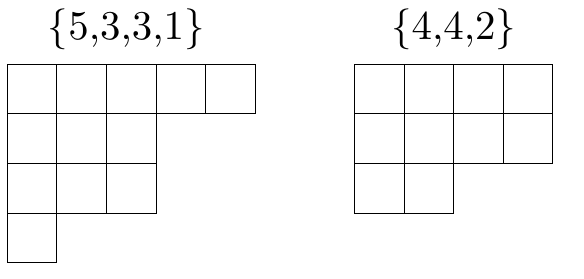
Figure 2 . Representation of excited states in terms of the integers r 1 (cid:20) (cid:21) 2 (cid:20) (cid:1) (cid:1) (cid:1) (cid:20) (cid:21) N de(cid:12)ned in (4.8) using Young